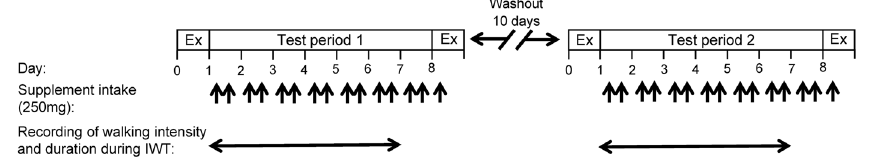
Figure 1. Experimental protocol. The study was conducted using a randomized, placebo-controlled, double- blind crossover design. Ex, graded cycling exercise test and depression severity assessment; IWT, high-intensity interval walking training. In each instance of supplement intake indicated by arrows, subjects ingested 250 mg of either 5-aminolevulinic acid (ALA) + sodium ferrous citrate (SFC) in the ALA + SFC trial or placebo supplement in the PLC trial at breakfast and at dinner (250 mg × 2 = 500 mg/day). See Supplemental Table S1 for details on the supplement compositions.